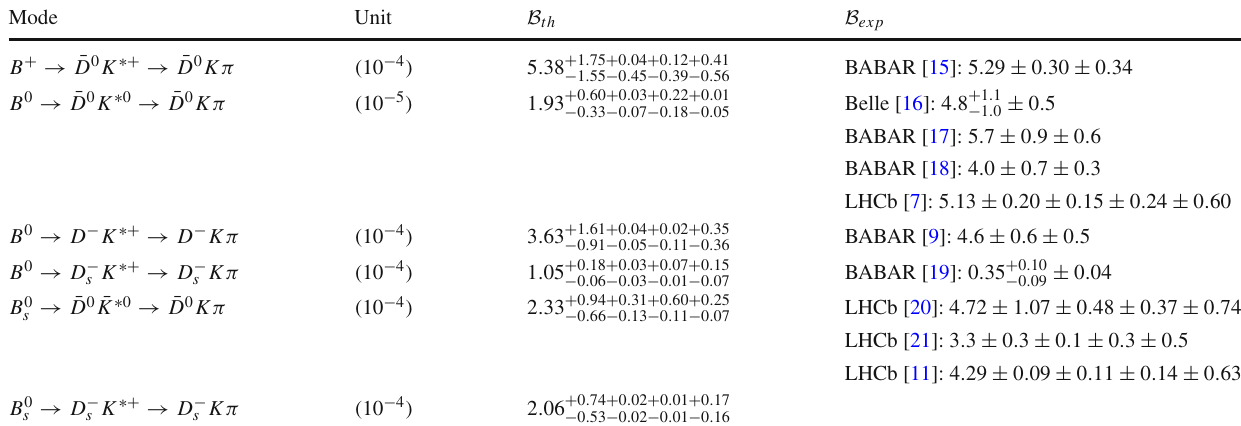
Table 1 The PQCD predictions for the branching ratios of the B ( s ) → ¯ D ( s ) K ∗ → ¯ D ( s ) K π decays in the quasi-two-body framework together with experimental data